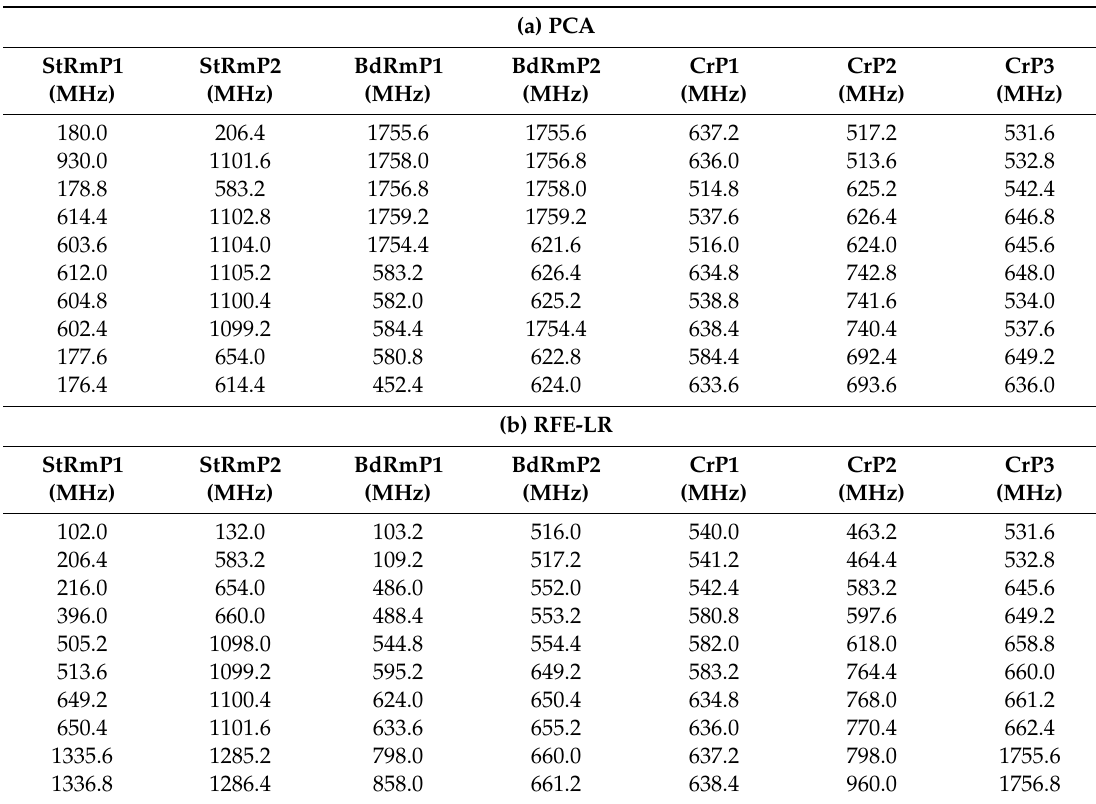
Table 3. The 10 frequency bands selected from 40 full band samples for 7 scenarios in the order from most significant to least